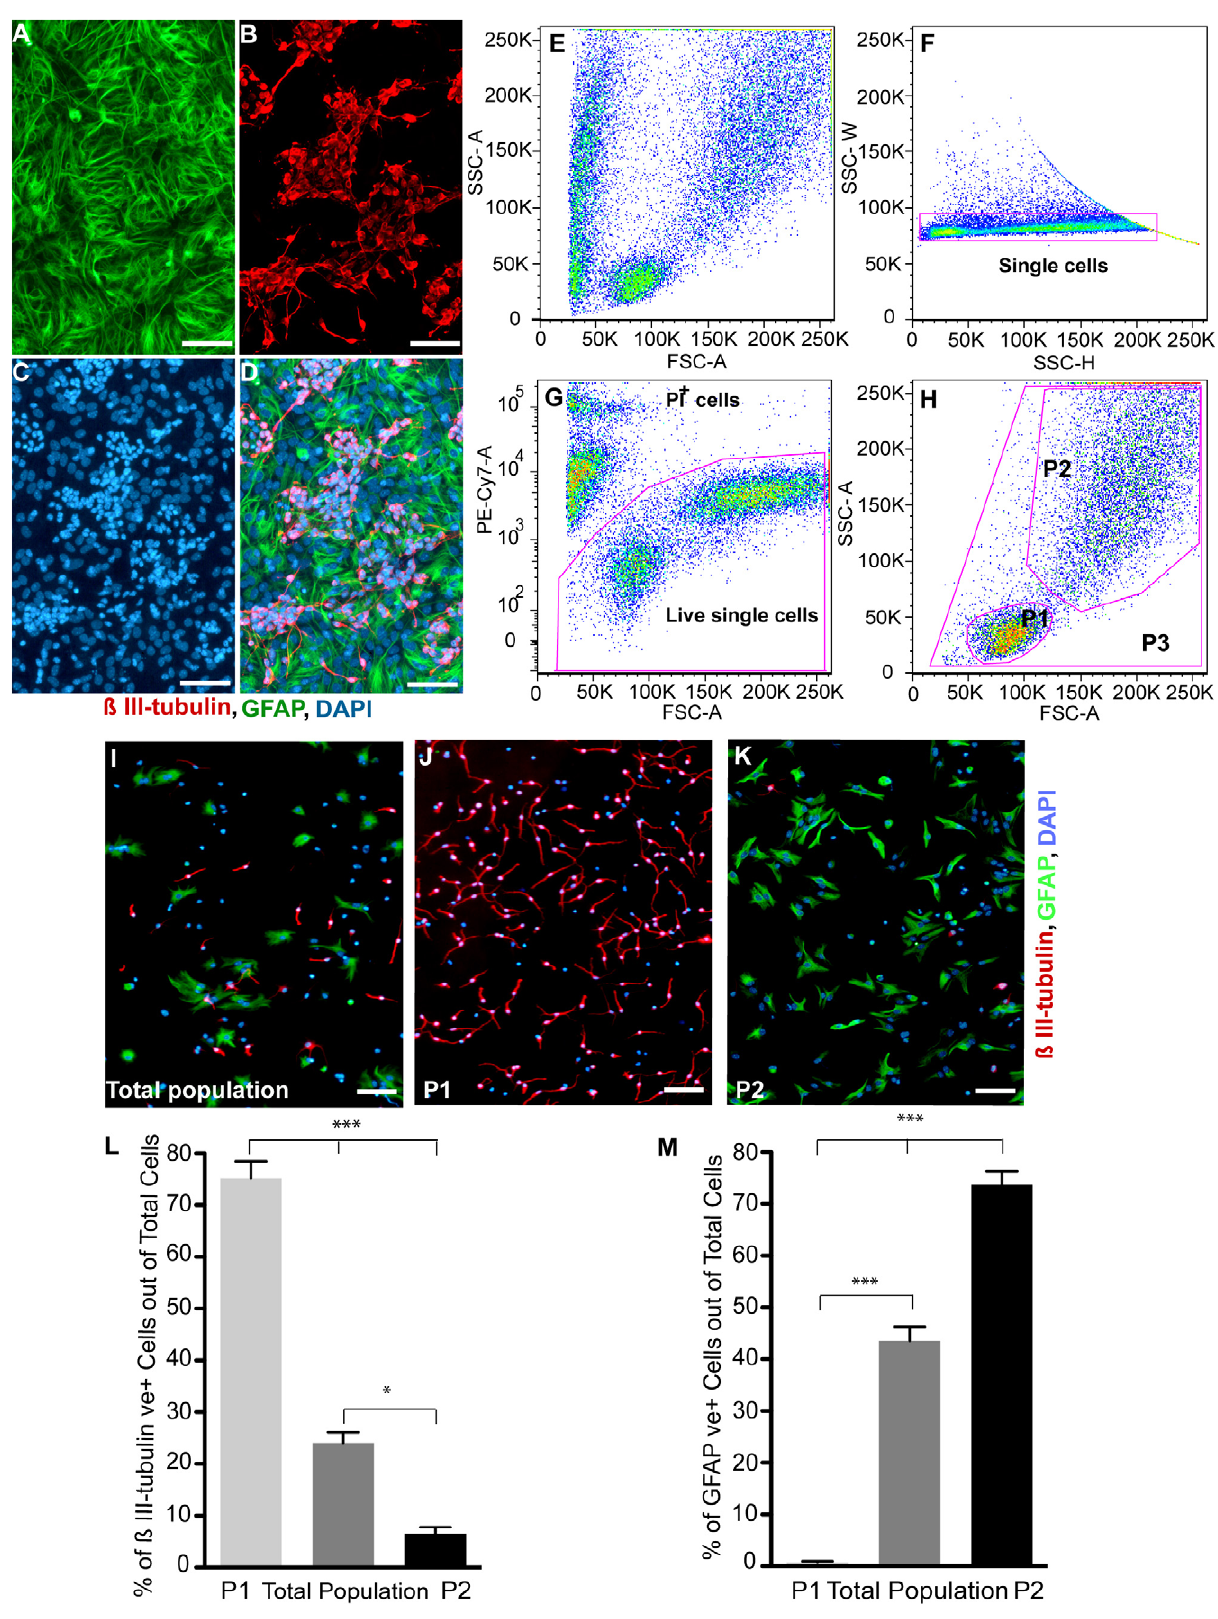
Figure 1. Differentiating neural stem cell progeny, cell sorting strategy and analysis of different populations post-sorting. ( A–D ): Representative micrographs of the neuroblast assay culture, 4 days after switching to growth factor free medium and stained for the astrocyte marker; GFAP ( A ), neuronal marker; b III-tubulin ( B ) and counterstained with DAPI( C ). Notice the colonies of b III-tubulin positive neuronal cells on top